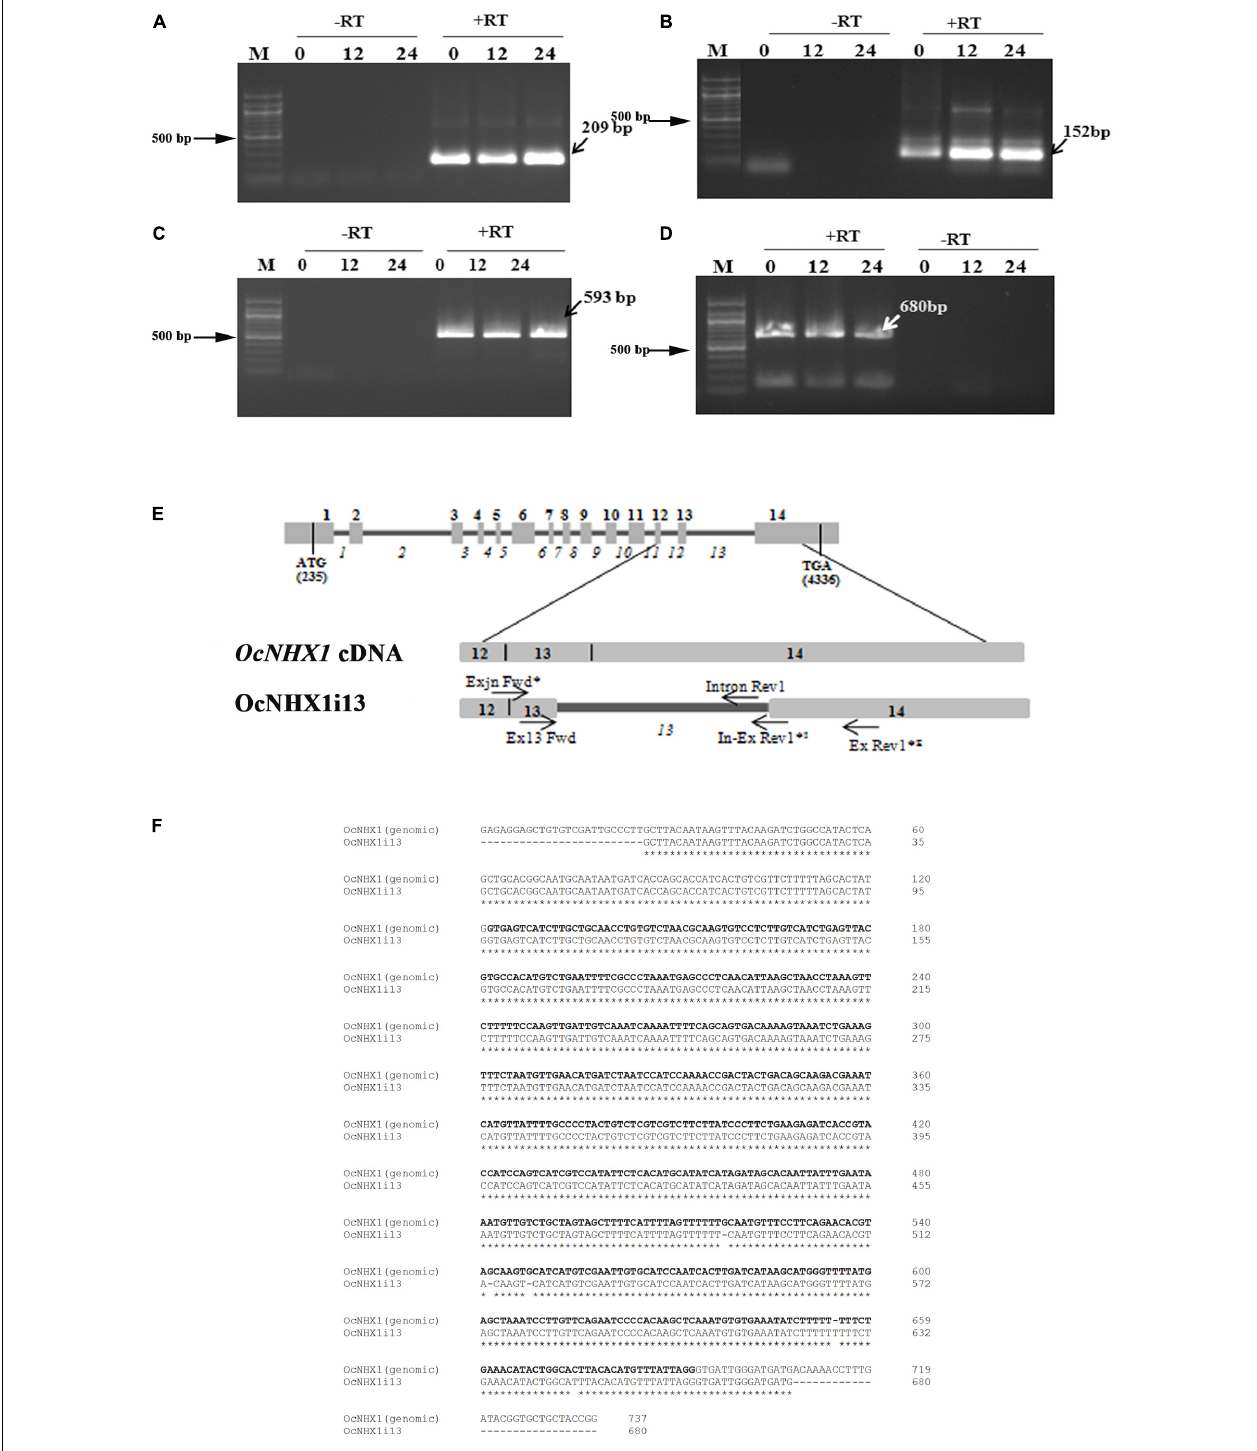
FIGURE 4 | Cloning of the 13th intron retaining splice variant from O. coarctata. Complete retention of the 13th intron in O. coarctata is confirmed by RT-PCR amplification using primer pairs listed in Supplementary Table S2 , generating fragments of sizes (A) 209 bp; (B) 152 bp; (C) 593 bp, and (D) 680 bp ( OcNHX1il3 ), respectively. In all cases a “RT-PCR” reaction was included to rule out genomic DNA contamination. (E) Schematic representation showing alignment of the OcNHX1il3 RT-PCR product with the corresponding OcNHX1 genomic region. Primer pairs used to isolate OcNHX1il3 by RT-PCR are indicated by an asterisk (*). (F) Alignment of OcNHX1il3 and corresponding OcNHX1 genomic sequence. The 680 bp fragment showed near 100% identity with the corresponding O cNHX1 genomic sequence (Accession no: JQ796375.1). The 13th intron is highlighted in bold.